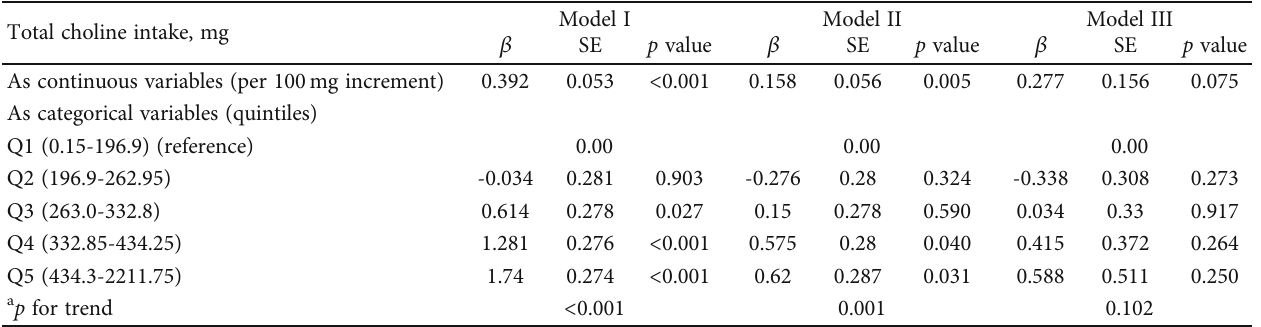
Table 4: Linear regression of total choline with DBP after excluding patients using antihypertensive drug ( n = 17296 ). Total choline intake, mg